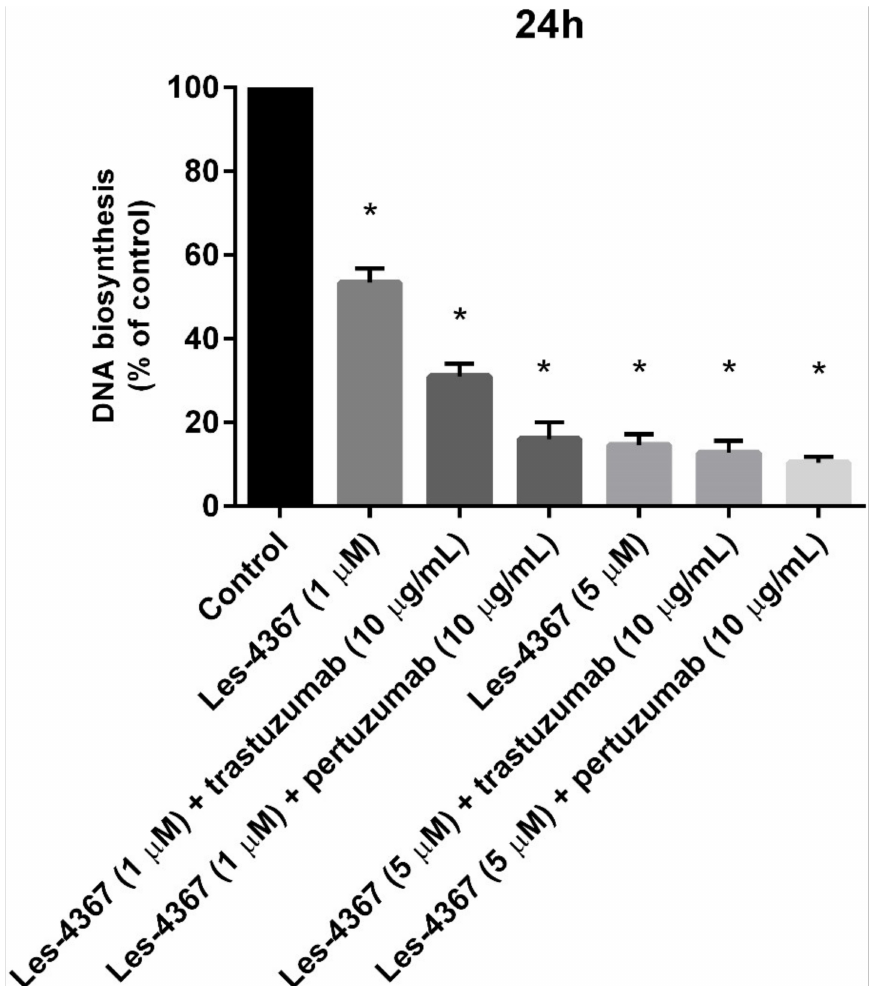
Figure 2. The antiproliferative effects of Les-4367 alone and combined with trastuzumab or per- tuzumab (trastuzumab + Les-4367, pertuzumab + Les-4367) in cultured AGS cells after 24 h incubation, as measured by inhibition of [3H]-thymidine incorporation into DNA. Mean ± SD from three inde- pendent experiments (n = 3) done in duplicate are presented. The ANOVA and Tukey tests were used to demonstrate differences between the control cells and the cells exposed to varying concentrations of the tested compounds. * p ≤ 0.05 vs. control